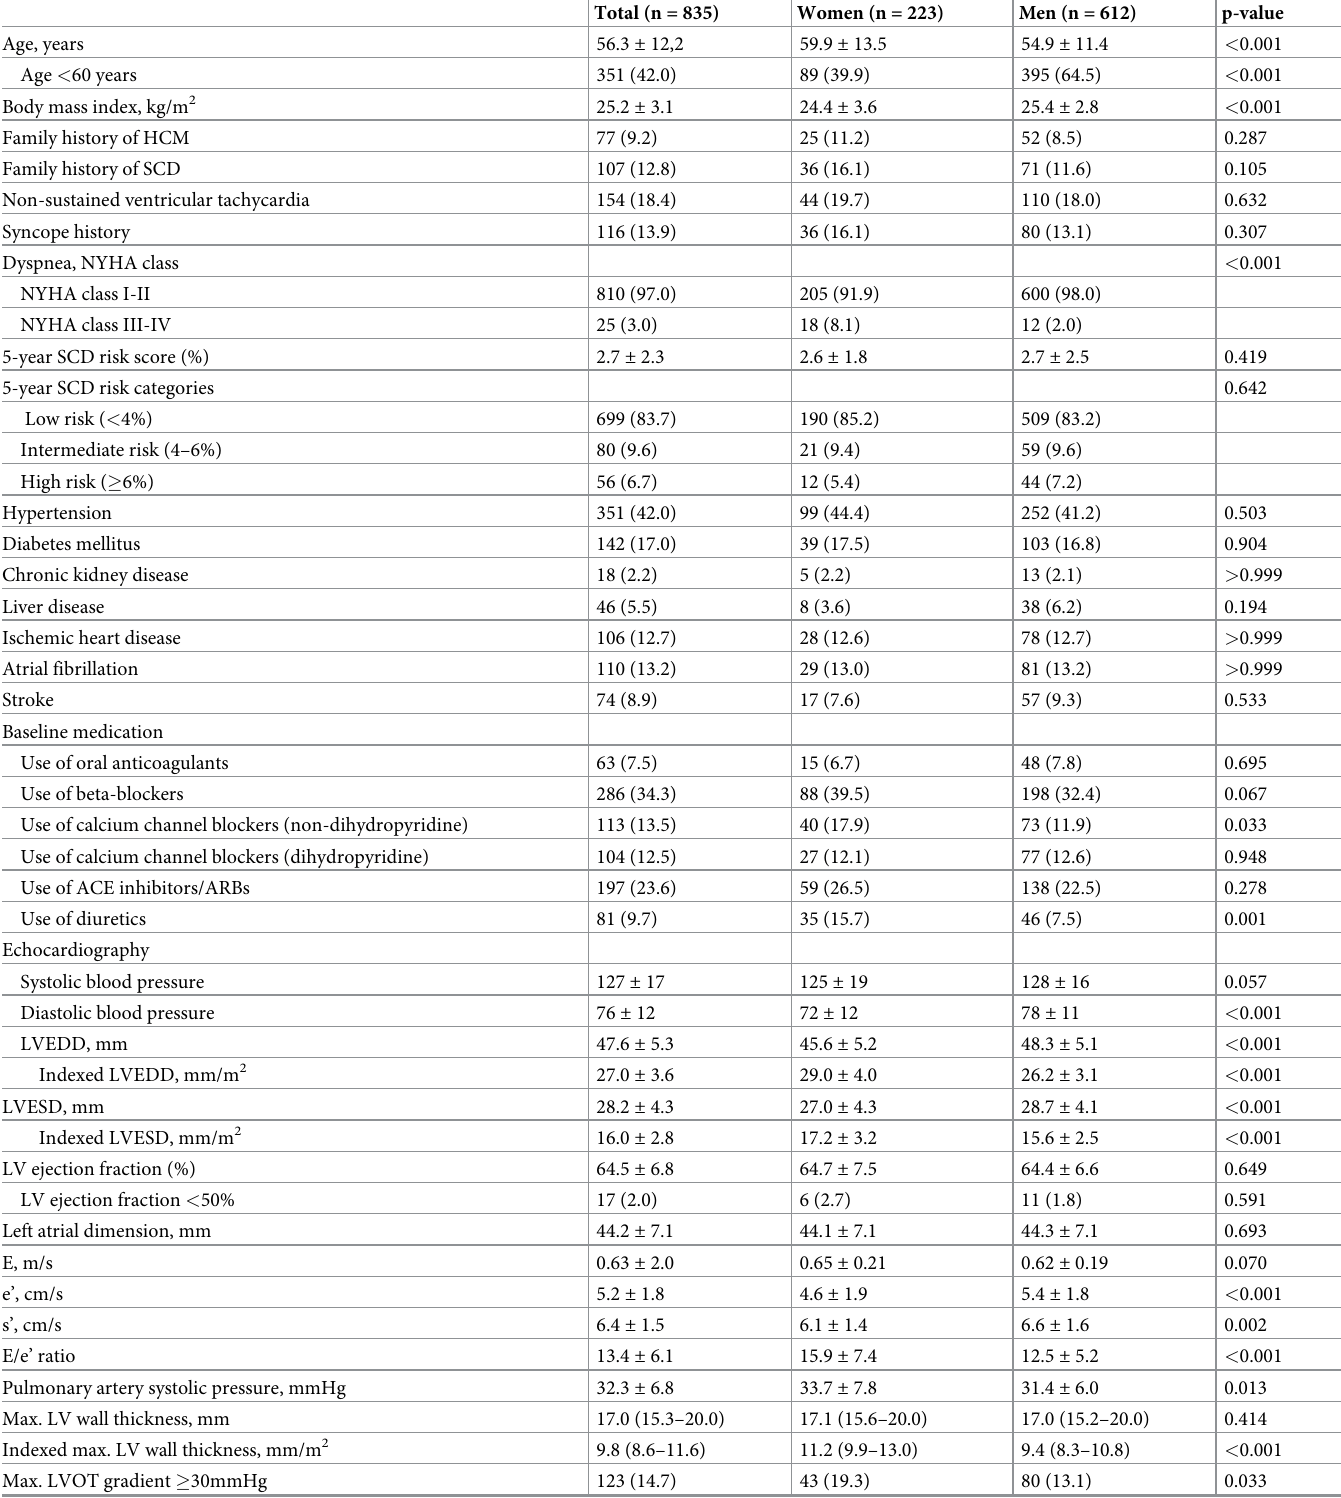
Table 1. Baseline characteristics of the total study